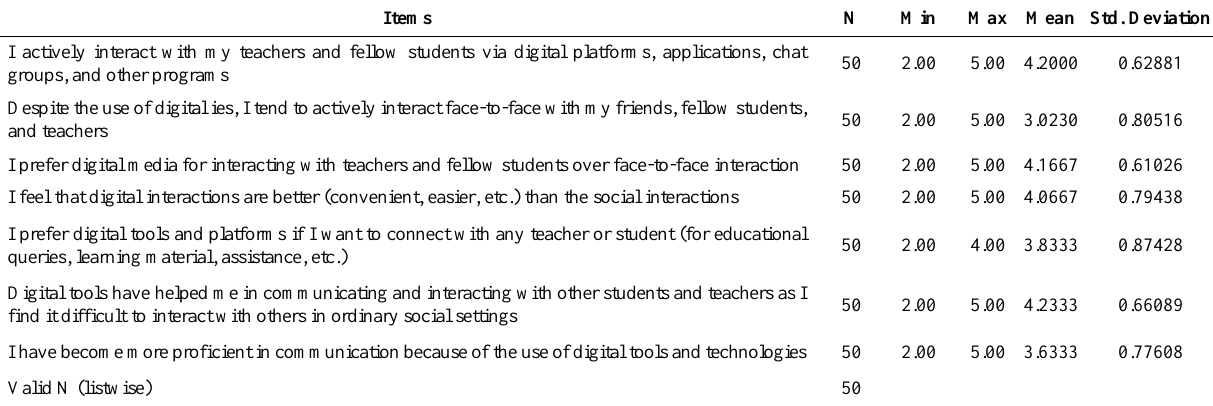
Table 3. Descriptive statistics of adolescents’ communicative